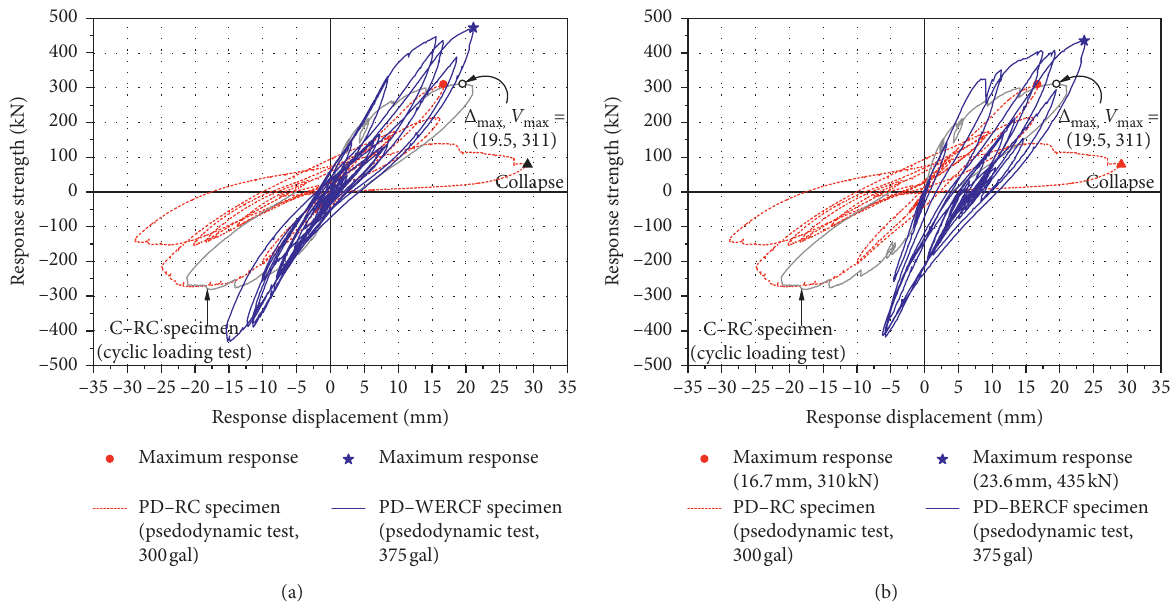
Figure 13: Lateral response load-displacement relationships for specimens strengthened with the ESRCF system during pseudodynamic testing at 375gal. (a) PD-WERCF; (b) PD-BERCF.